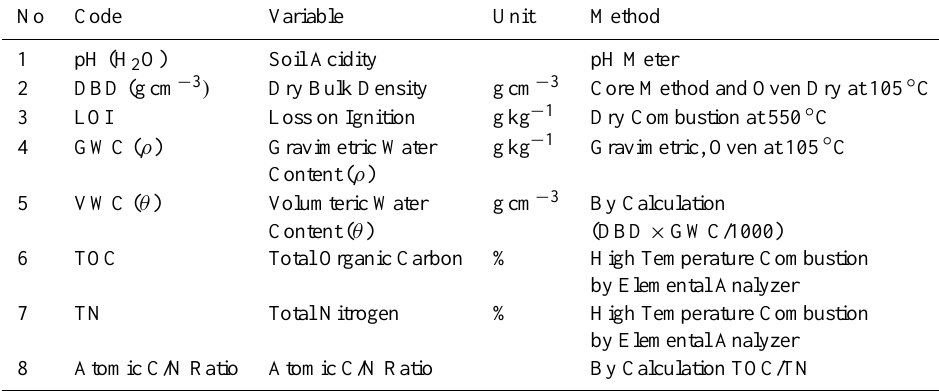
Table 5. A list of research variables in this